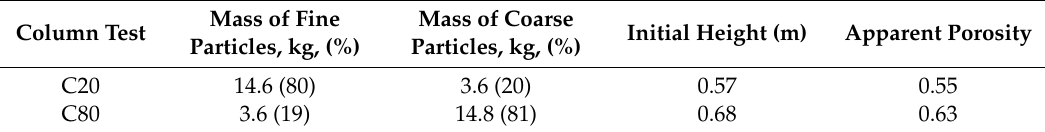
Table 3. Composition of fine material and coarse material in both